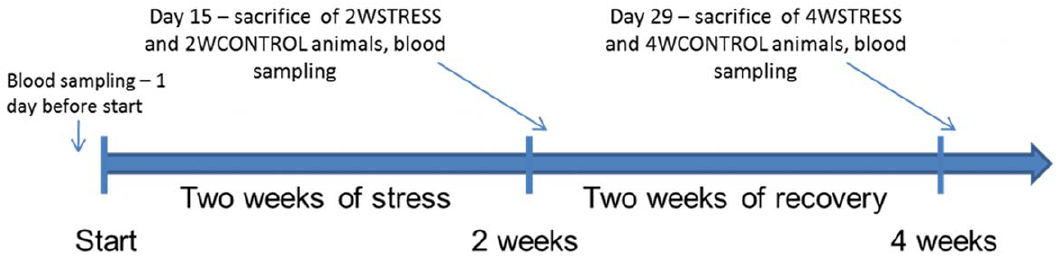
Figure 12. Time course of the experimental manipulations. 24 animals were randomly assigned to one of the following experimental groups: two weeks of daily restraint stress (2WSTRESS, n=6), two weeks naive controls (2WCONTROL, n=6), two weeks of daily restraint stress + two weeks of recovery from stress (4WSTRESS, n=6), four weeks naive controls (4WCONTROL, n=6). Animals were sacrificed immediately after stress (2 weeks), or after two weeks of recovery from stress (4